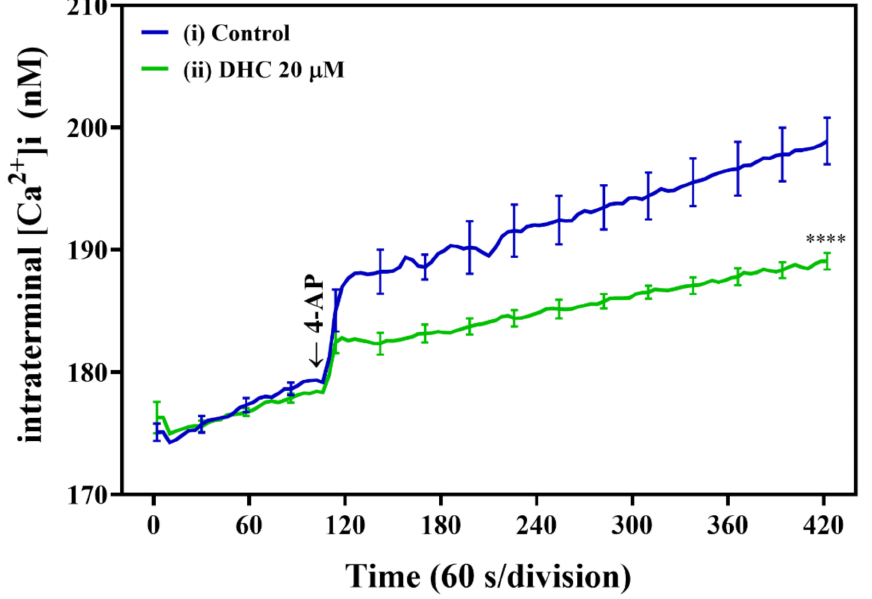
Figure 4. DHC reduced the 4-AP-induced increase in [Ca 2+ ]i in mouse cortical brain synaptosomes. Synaptosomes were incubated with Fura-2 AM, followed by treatment with DHC (20 µ M) as de- scribed. Representative ([Ca 2+ ]i curves in the presence of DHC and 4-AP (1 mM) are plotted versus time. **** p < 0.0001 versus the control group ( n =